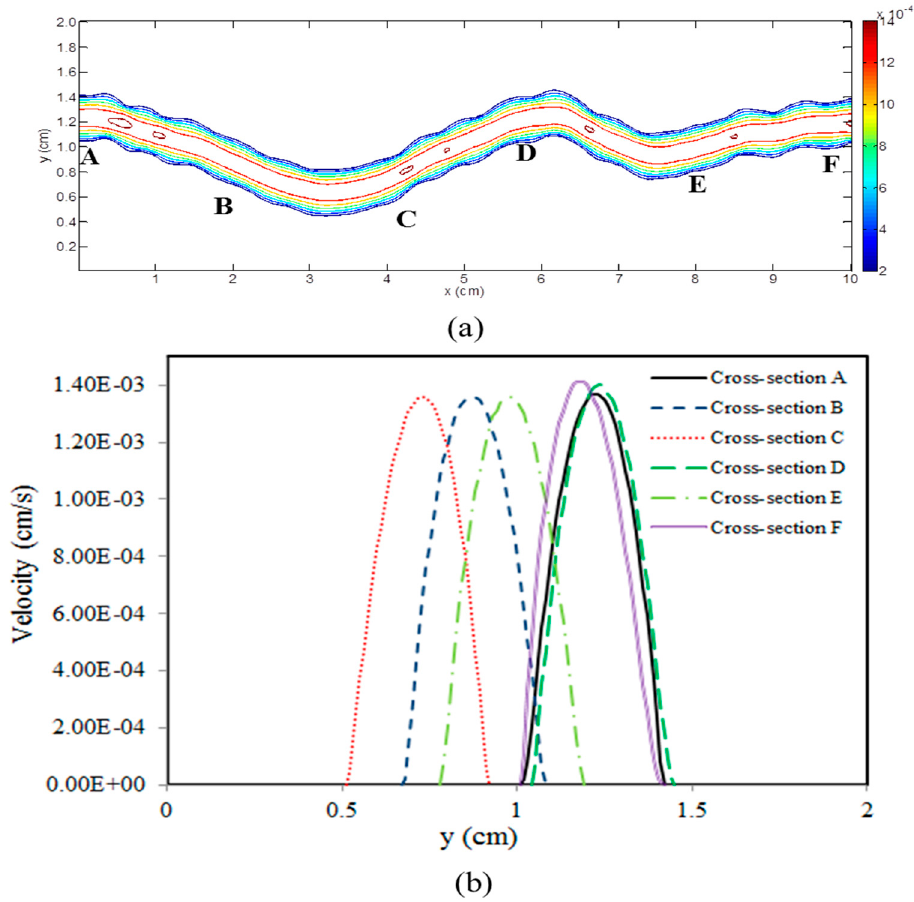
Figure 5. The mass conservation for fluid flow through rough fracture: ( a ) the velocity distribution for the fluid flow in the fracture with JRC = 17~18 and aperture = 0.4 cm; ( b ) the velocity profile at different locations.